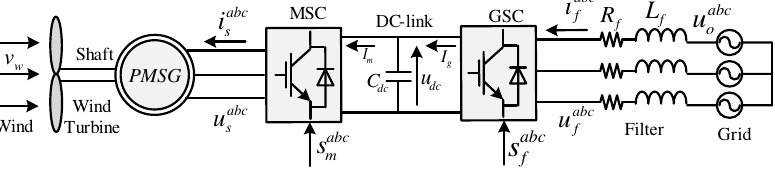
Figure 1. Structure of modern wind turbines with permanent-magnet synchronous